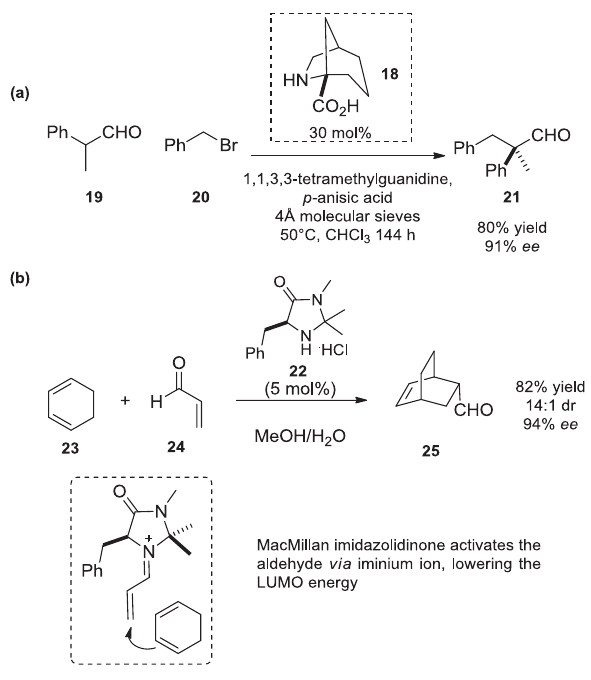
Figure 7. (a) Asymmetric alkylation of α -branched aldehydes catalyzed by secondary amine 18; (b) direct Diels – Alder reaction catalyzed by MacMillan imidazolidinone